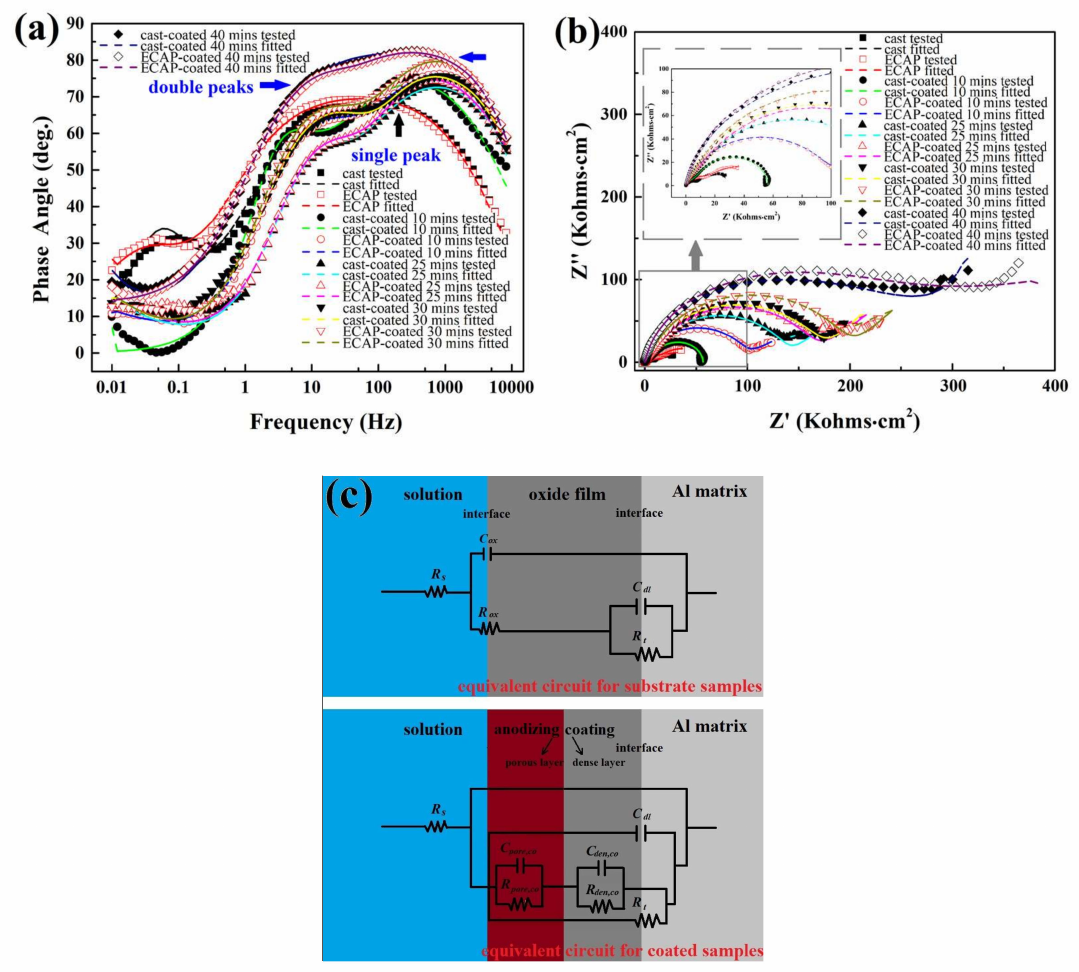
Figure 5. Electrochemical impedance spectroscopy (EIS) Bode plots ( a ), Nyquist plots ( b ) of the coated and substrate samples in NaCl solution, and the illustration of equivalent circuits ( c